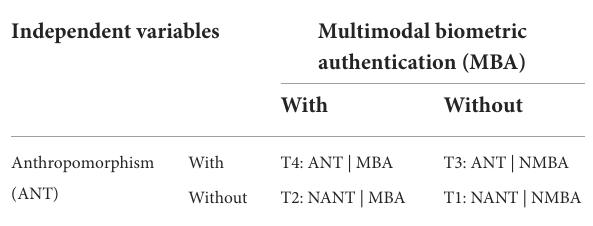
TABLE 3 2 × 2 Factorial